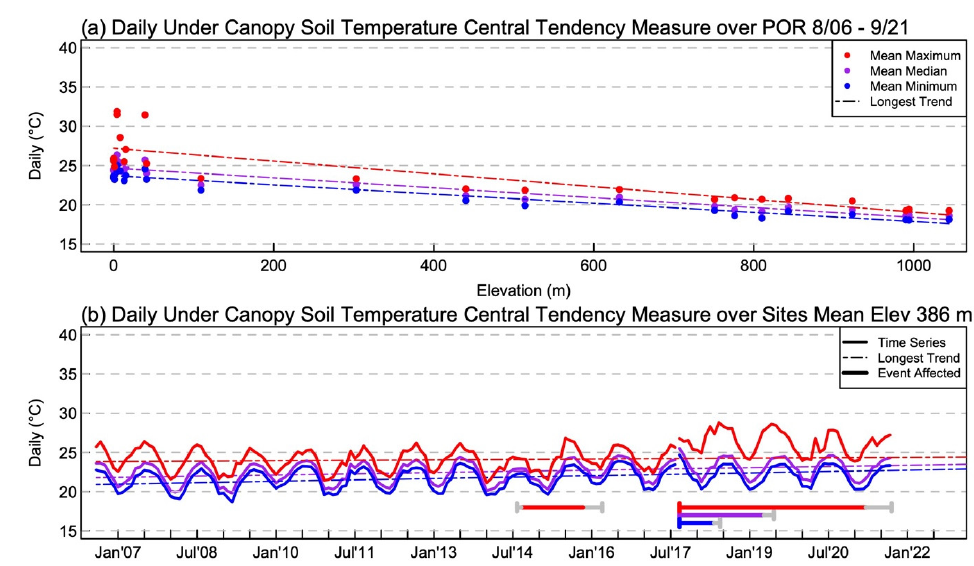
Figure 4. Average of the statistical calculations on the under-canopy soil temperature for daily maximum, median, and minimum. Plot ( a ) shows the site period of record average values as points with the trend lines of magnitude with elevation. Plot ( b ) shows the periodic component timeseries (each 1 month or 4 months) averaged over the sites as thick lines, with thin dashed trend lines of magnitude with time at the average site elevation (386 m). The colors signify the same variable across the plots. Only the longest trend calculated is shown, from the pre-hurricane data. The estimated event-affected (drought then hurricane) periods are shown in thick bars on the bottom of plot with the gray part of the bars as the 90% confidence intervals around the end points. Table 2. Region-Wide Linear Least Squares Relationships of Temperature with Elevation (x, in km).